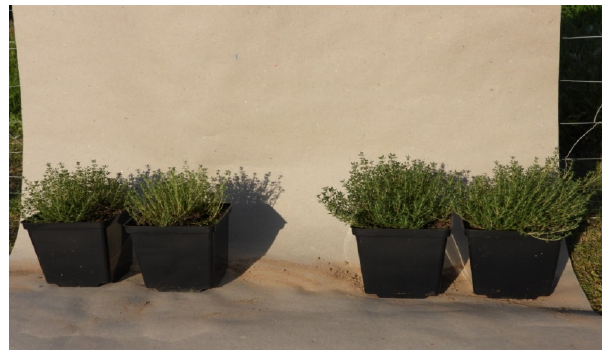
Figure 1. Pot plantation of four herbs (from the top: lovage, marjoram, rosemary and thyme) . In these photographs, pots watered with non-treated water and watered with LPGPA are situated on the left and right, respectively).